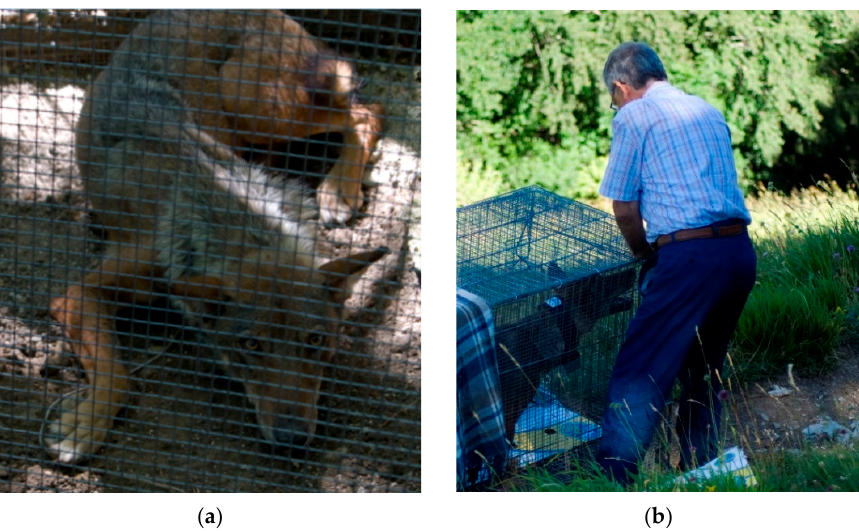
Figure 2. Carlina the wolf: ( a ) in the rehabilitation centre of “Parco Faunistico Piano dell’Abatino”; ( b ) immediately before the release in the area where she was found.